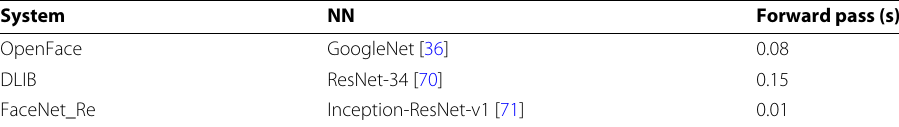
Table 7 Feature extraction time per